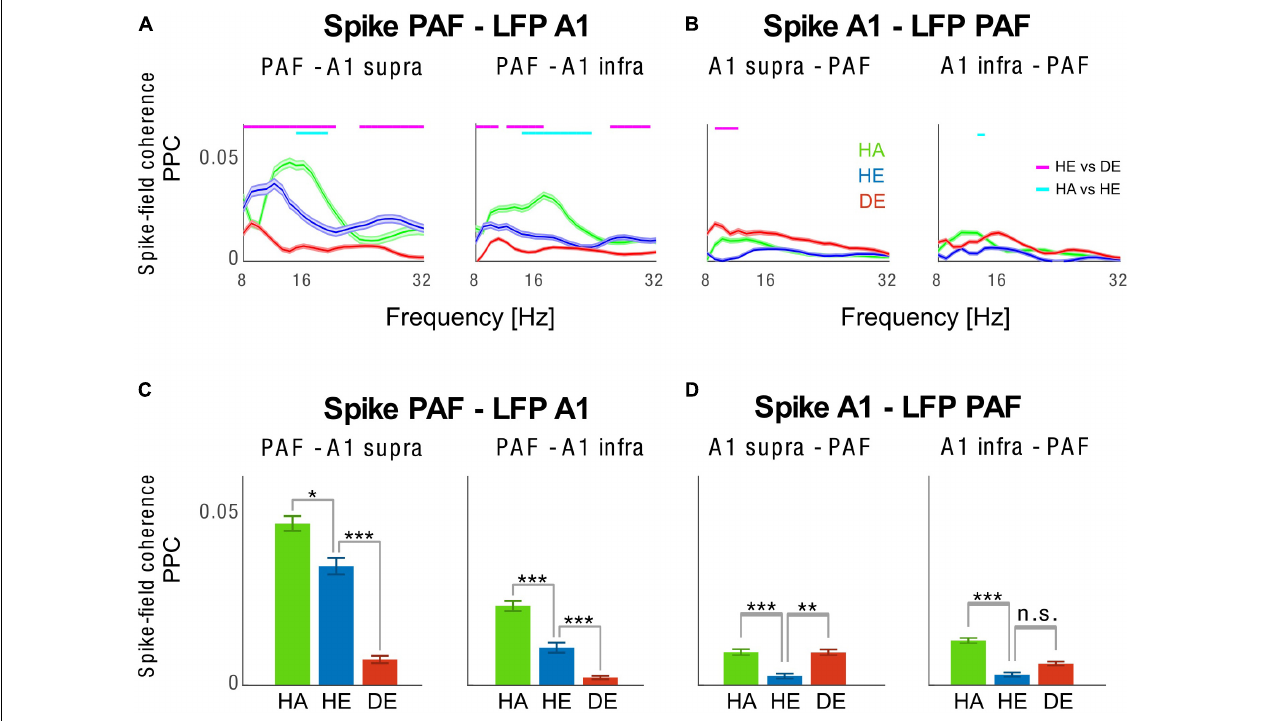
FIGURE 5 | Inter-areal spike-field coherence between A1 and PAF. (A) Spike-field coherence spectra computed with pairwise phase consistency (PPC) for PAF spikes–A1 supragranular LFPs (left panel) and PAF spikes–A1 infragranular LFPs (right panel). Shaded areas show the standard error of the mean. (B) Spike-field coherence spectra were computed with PPC for A1 supragranular spikes – PAF LFPs (left panel) and A1 infragranular spikes–PAF LFPs (right panel). Statistical pairwise comparisons are shown for electric control vs. deaf (magenta line above the graph) and animals with intact cochleae vs. acutely deafened cochleae (cyan line above the graph) using the two-tailed Wilcoxon rank-sum test (false discovery rate corrected, p < 0.001). (C,D) Bar plots of spike-field coherence are plotted in the same order as in panels (A,B) , representing the frequency of 10 Hz alpha. HA (green) Acoustic Controls, HE (blue) Electric Controls, DE (red) Congenitally Deaf Cats. n.s. not significant, * p < 0.05, ** p < 0.01, *** p < 0.001, two-tailed t -test statistics. A1, primary auditory cortex; PAF, posterior auditory field; LFP, local field